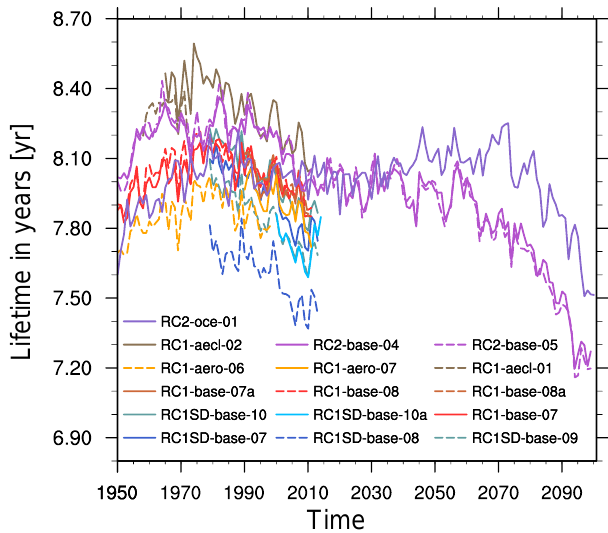
Figure 18. Annually averaged methane lifetime with respect to OH of the different simulations calculated with Eq.